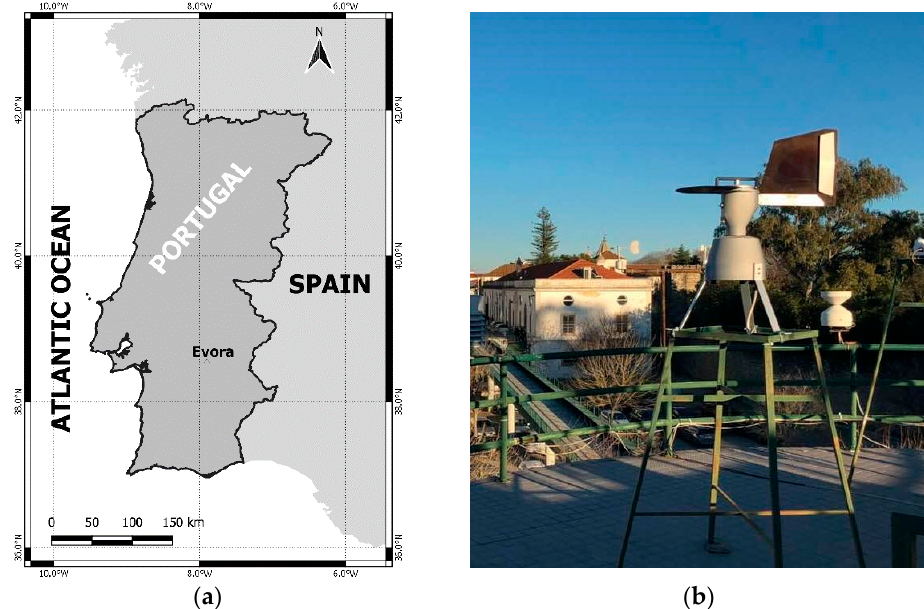
Figure 1. Map of Portugal illustrating the location of Évora ( a ) and photo of EVASO where the Hirst type pollen trap and the weather station are installed ( b ).